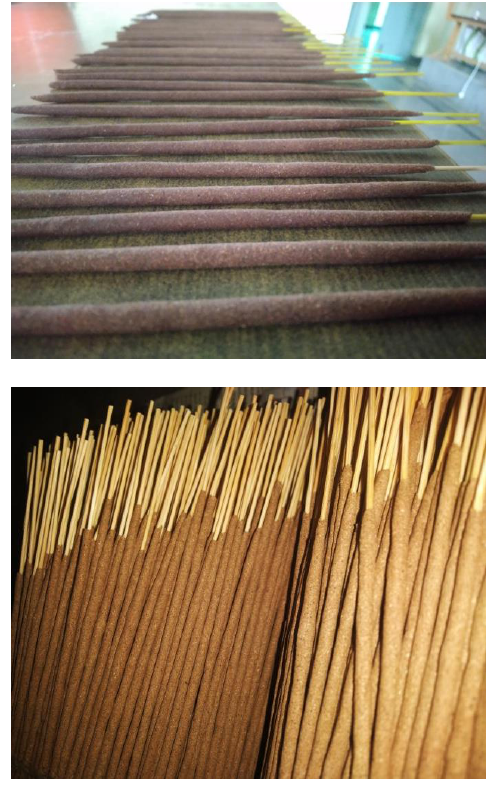
Figure 9. Handmade incense sticks made of flower